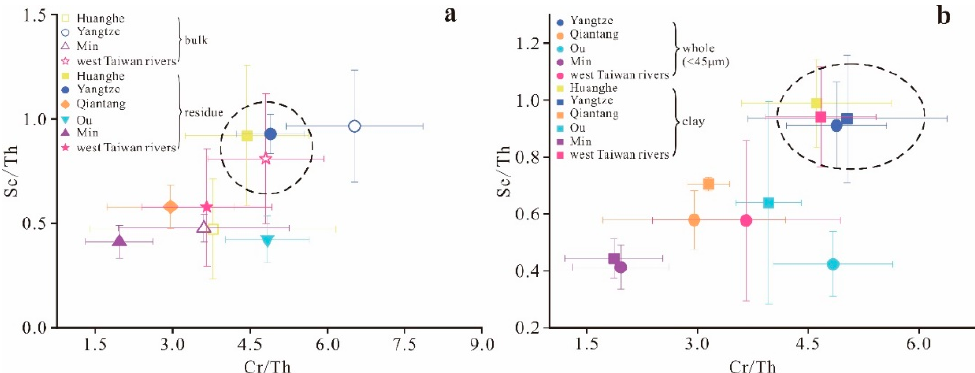
Figure 4. Effects of chemical partition ( a ) and grain size ( b ) on sediment provenance discrimination (error bar for 2 σ ).